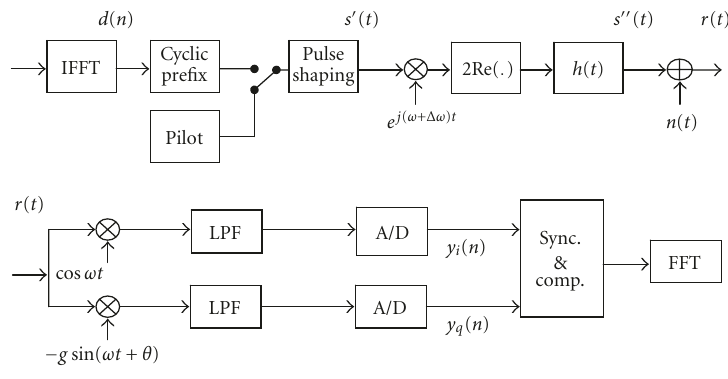
Figure 1: Block diagram of the transmitter and receiver in the OFDM